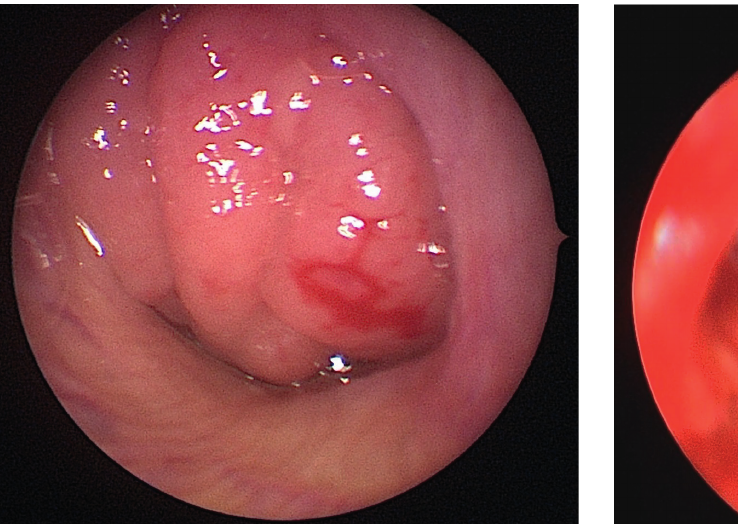
Figure 3. Endoscopic view of the inferior aspect of the left nasal cavity